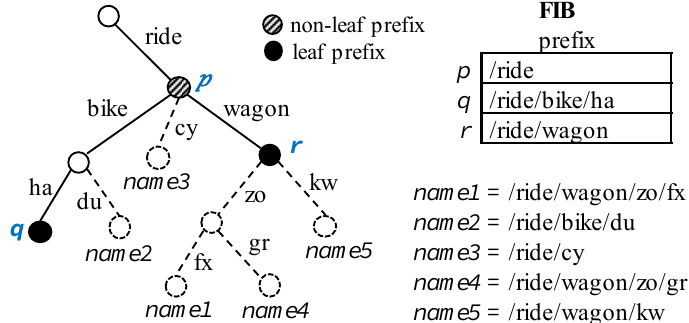
Figure 2. Example of name prefix caching in forwarding information base (FIB) containing three prefixes: p , q , and r .